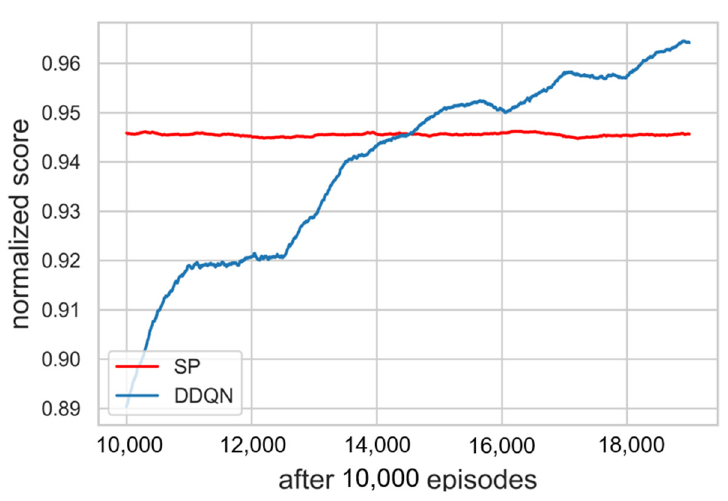
Figure 6. Learning curves after 10,000 episodes. The score of the DDQN was recorded higher as compared with SP after 15,000 episodes.